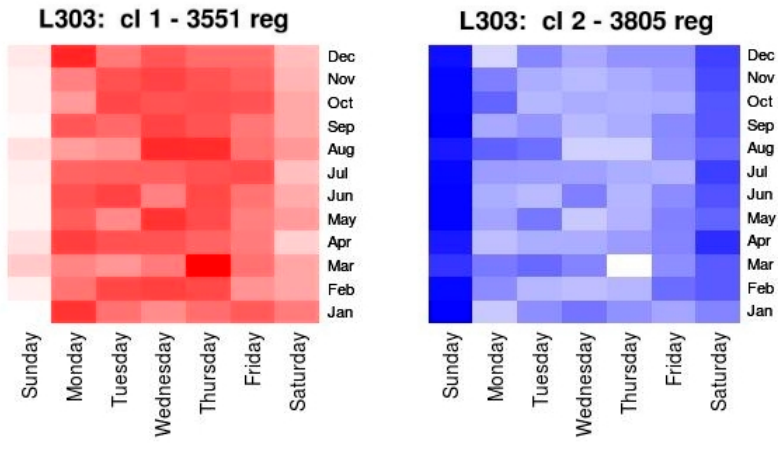
Figure 5. Heatmaps of k-medoids with two clusters showing the relation of their records with the months of the year and the days of the week.